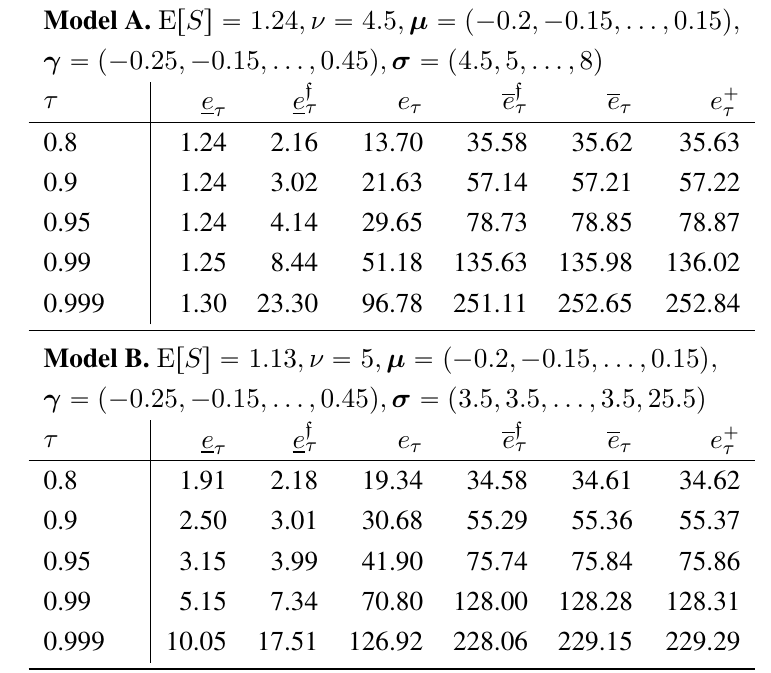
lists values for a multivariate skew- t distributed X with a τ